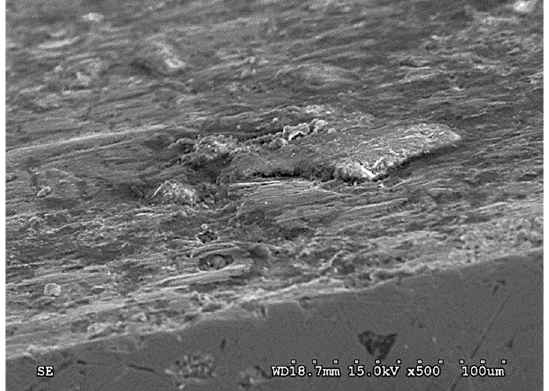
Figure 9. Cracks in the surface layer of the chain wheel made of ADI_240_D (SEM; cross-section).